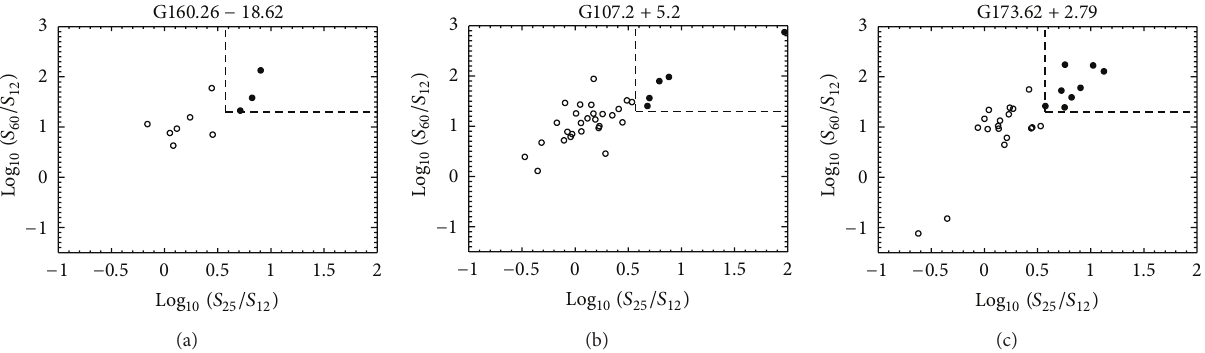
Figure 2: Colour-Colour plots of IRAS sources in the vicinity of Perseus (a), G107.2+5.2 (b), and G 173.6+2.79 (c) AME regions. The colours are calculated for sources within 1 ∘ of the central source positions using the IRAS PSC. UCHII region candidates, shown as solid-filled circles, have ratios log 10 (𝑆 60 /𝑆 12 ) ≥ 1.30 and log 10 (𝑆 25 /𝑆 12 ) ≥ 0.57 , corresponding to the top-right hand corner of this plot (marked with a dashed